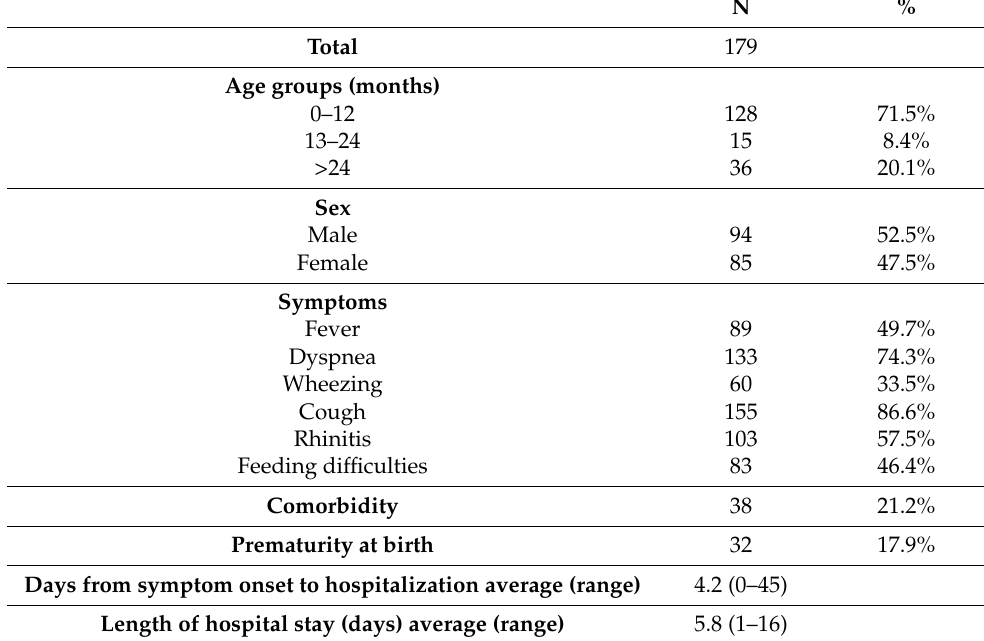
Figure 1. Epidemic curves of RSV hospitalizations in children, years 2017–2021. Compared with previous seasons, in which hospitalizations peaked during February, the 2021 outbreak began much later in the year and peaked in November. Between August and December 2021, 179 children were hospitalized for RSV infection, including 136 (76%) infected with RSV B, 41 (23%) infected with RSV A, and two (1%) with both. The demographic and clinical characteristics of these patients are summarized in Table 1. Table 1. Demographic and clinical data of children hospitalized for RSV infection in 2021.